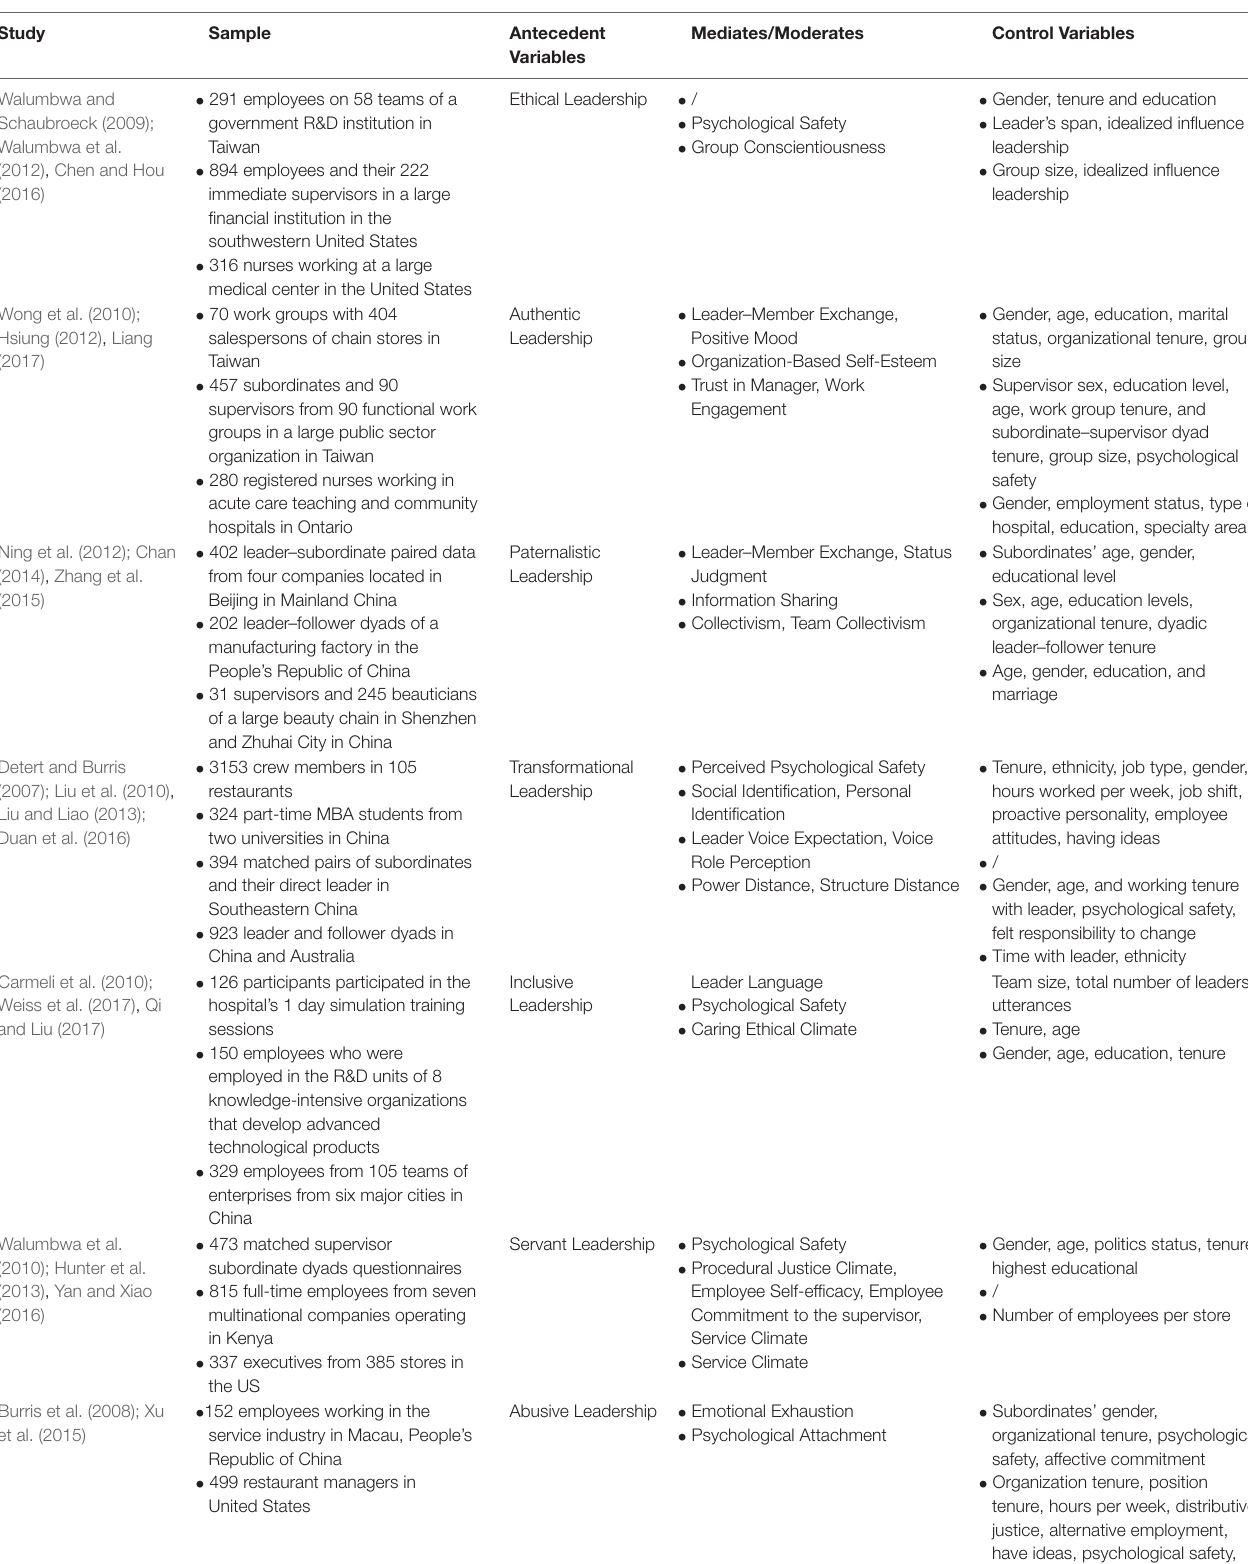
TABLE 1 | Empirical research on leadership and voice behavior. Study